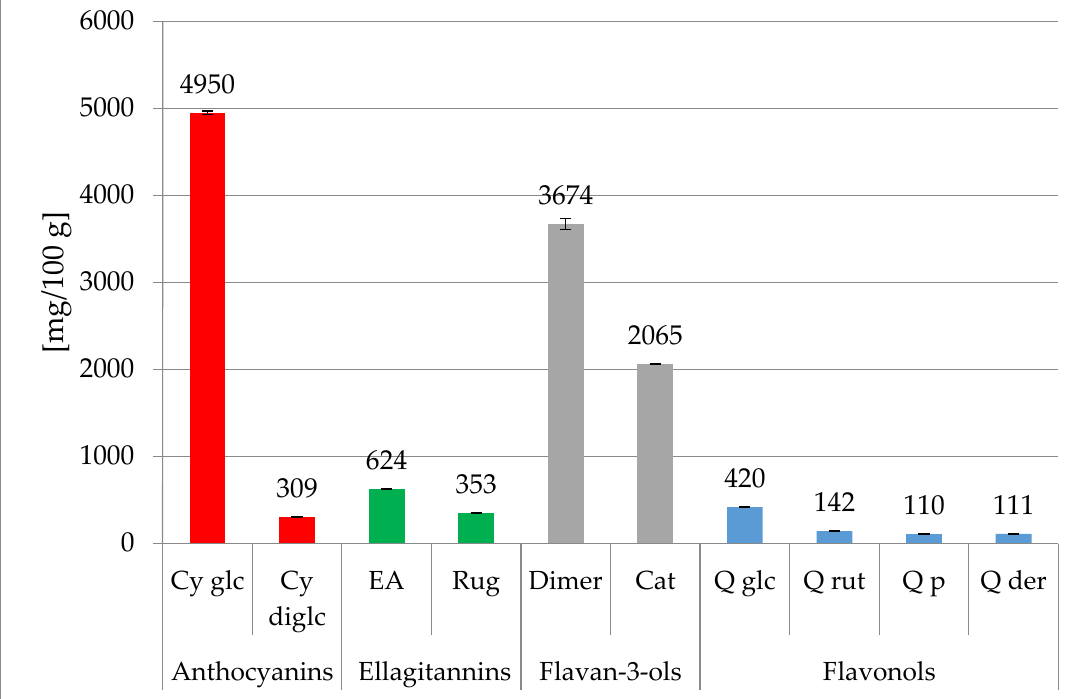
Figure 1. Content of phenolic compounds (Cy glc: cyanidin 3-O-glucoside; Cy diglc: cyanidin 3,5-O-diglucoside; Dimer: procyanidin dimer; Cat: (+)-catechin; EA: ellagic acid; Rug: rugosin; Q glc: Quercetin 3-O-glucoside; Q rut: Quercetin 3-O-rutinoside; Q p: Quercetin 3-O-pentoside; Q der: Quercetin derivative in the purified dry extract from fruits of Rosa spinosissima ). The bars represent mean values of three experiments ± SD.